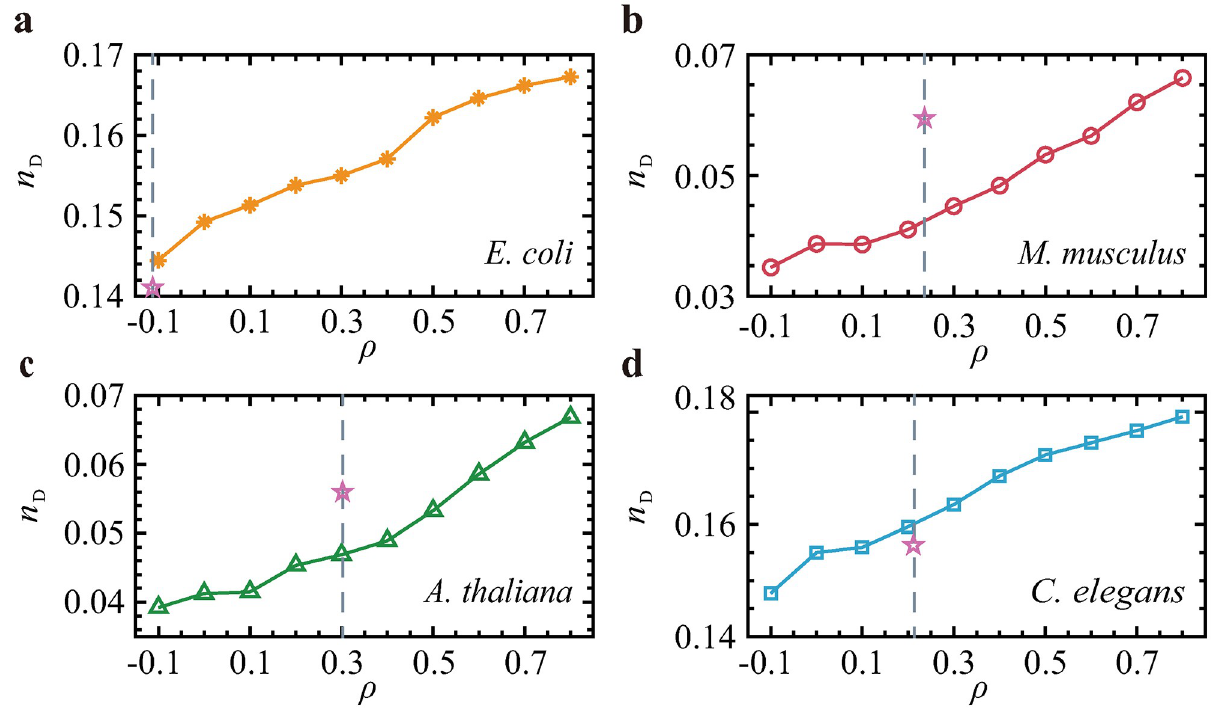
Fig 4. The minimal numbers of driver nodes as functions of the degree-degree correlations between the layers of TRN-PPI multiplex networks. (a) E. coli , (b) M. musculus , (c) A. thaliana , and (d) C. elegans . The gray dashed lines show the real values of the interlayer degree-degree correlations, and the purple pentagrams show the real values of n D for the real connections between layers. Each data point is the mean of 100 independent realizations.